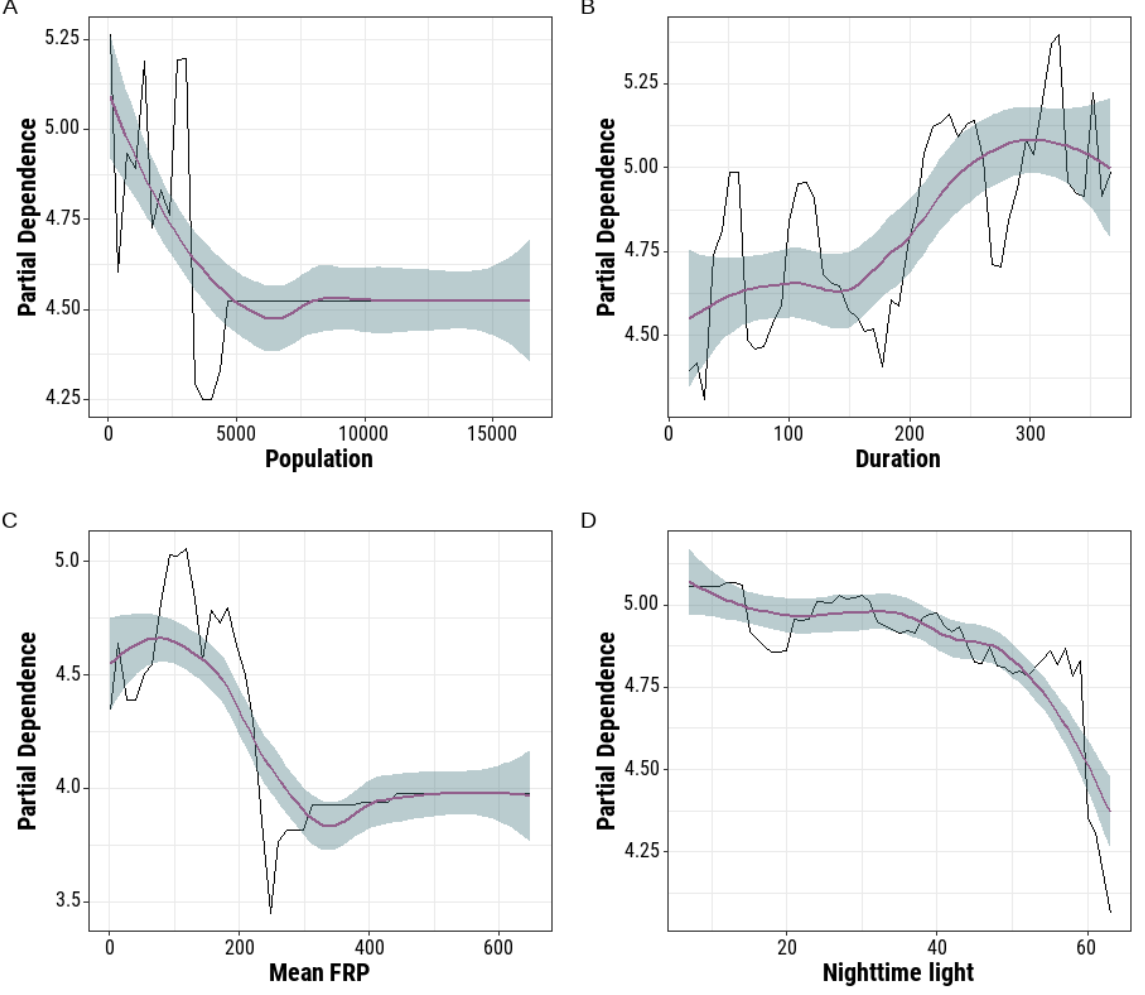
Figure 11. Partial dependence curves representing the relationships between the carbon emission amounts and Population ( A ), Duration ( B ), Mean FRP ( C ) and Nighttime Light ( D ). The purple lines represent smoothed conditional means and the green areas represent 95% confidence intervals.